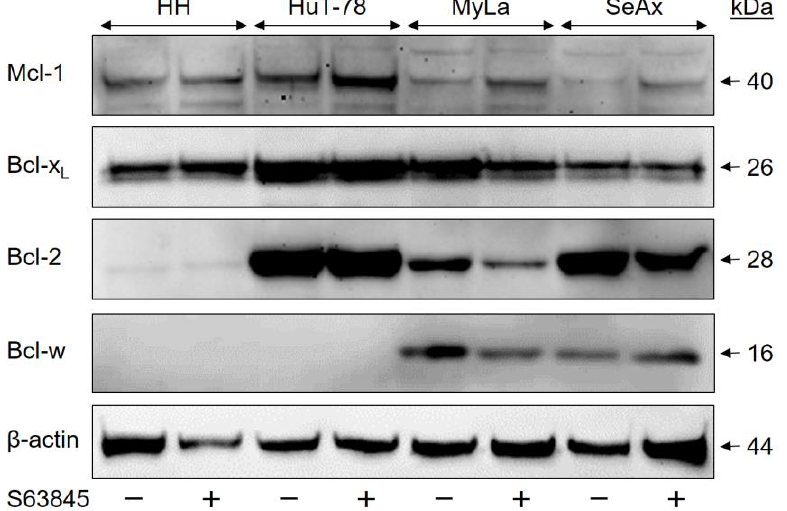
Figure 6. Variant expression of the Bcl-2 family proteins in CTCL cells. CTCL cell lines treated for 48 h with S63845 (1 µM, +) were compared to control cells (DMSO, − ). In each lane, 30 µg of proteins were loaded. Blots were probed with antibodies for Mcl-1 (40 kDa), Bcl-x L (26 kDa), Bcl-2 (28 kDa) and Bcl-w (16 kDa). The housekeeping protein β -actin (44 kDa) was used as a loading control. Three independent series of protein extracts and Western blotting experiments revealed highly comparable